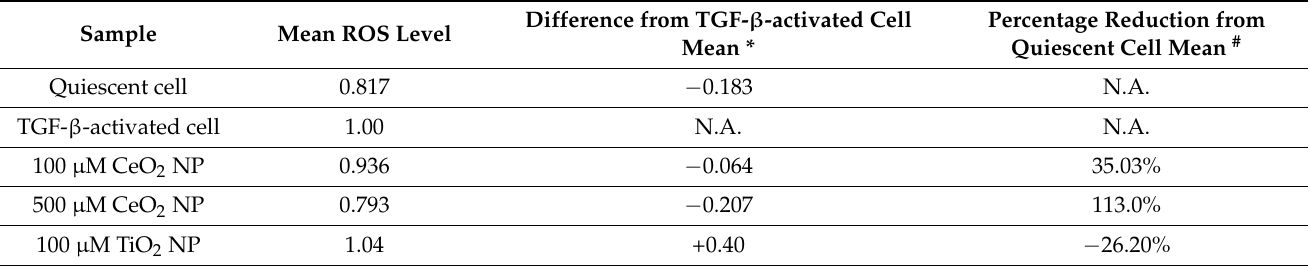
Table 1. ROS-level reduction in CeO 2 -treated cells.